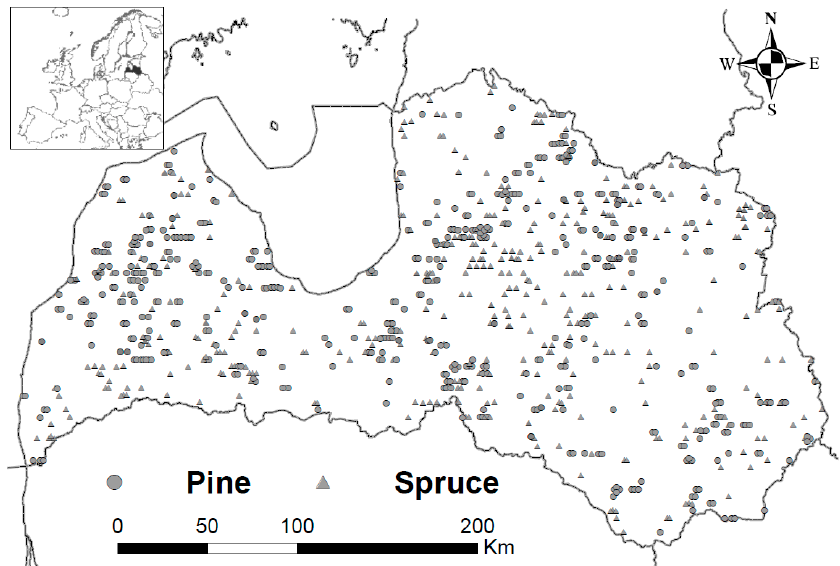
Figure 1. The locations of the sampling plots in the territory of Latvia.